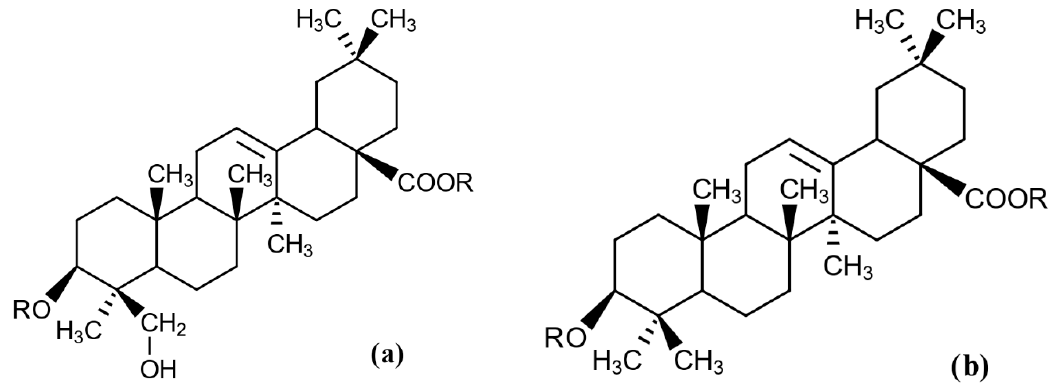
Figure 5. Molecular structures of sapogenins found in different varieties of quinoa: hederagenin ( a ) and oleanolic acid ( b ).